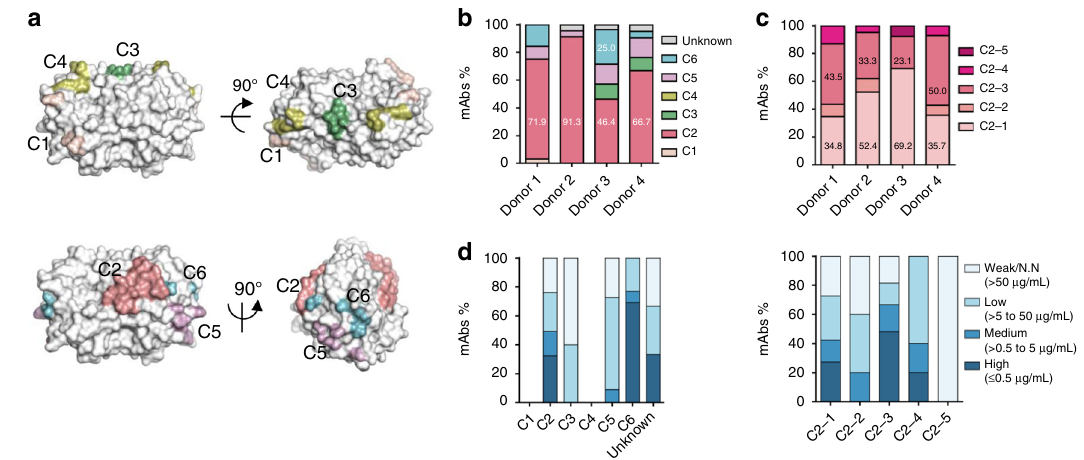
Fig. 3 Epitope-function mapping of HEV vaccine-induced p239(1)-speci fi c mAbs. a Location of six distinct antigenic clusters (C1 – C6) on the protruding domain of the HEV capsid. The color-coding scheme is described as follows: C1 (pink), C2 (red), C3 (green), C4 (yellow), C5 (purple), and C6 (blue). b Percentage of mAbs directed to each antigenic site, color-coded as in ( a ). c Percentage of mAbs directed to fi ve subtypes of antigenic site C2. d Antibody-neutralizing activity (IC 50 ) plotted against the antigenic site. Left: C1 – C6; right: C2 – 1 to C2 – 5. IC 50 is divided into four ranges as shown in Fig. 2e, f. The antigenic sites recognized by at least two mAbs are analyzed in ( d ). Source data are provided in the Source Data fi consistent with the fi nding that the majority of p239(1)-speci fi c mAbs isolated from 3M1, while showing a low level of SHM (Supplementary Fig. 13a), possess long CDRH3 loops (Supple- mentary Fig. 13b). Taken together, the NGS analysis provided a HEV vaccination.